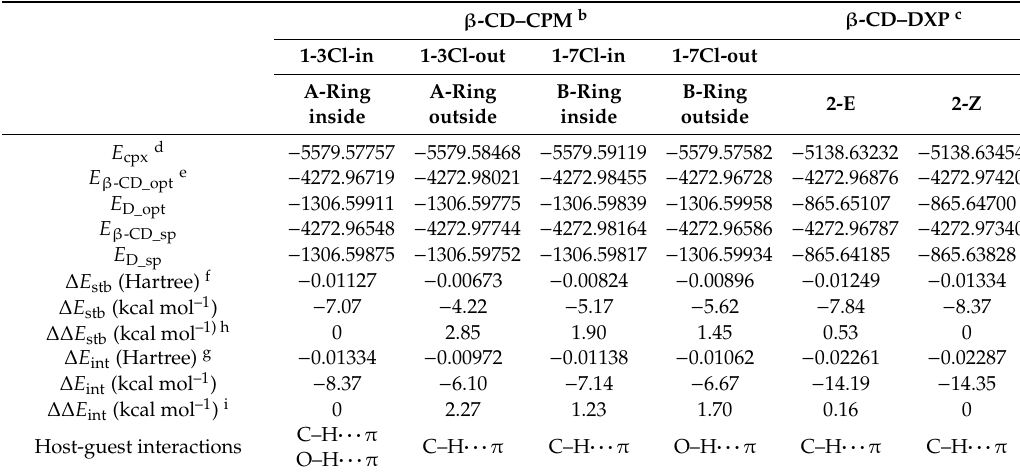
Table 3. Stabilization and interaction energies of β -CD inclusion complexes with isomeric CPM and DXP from DFT full-geometry optimization.